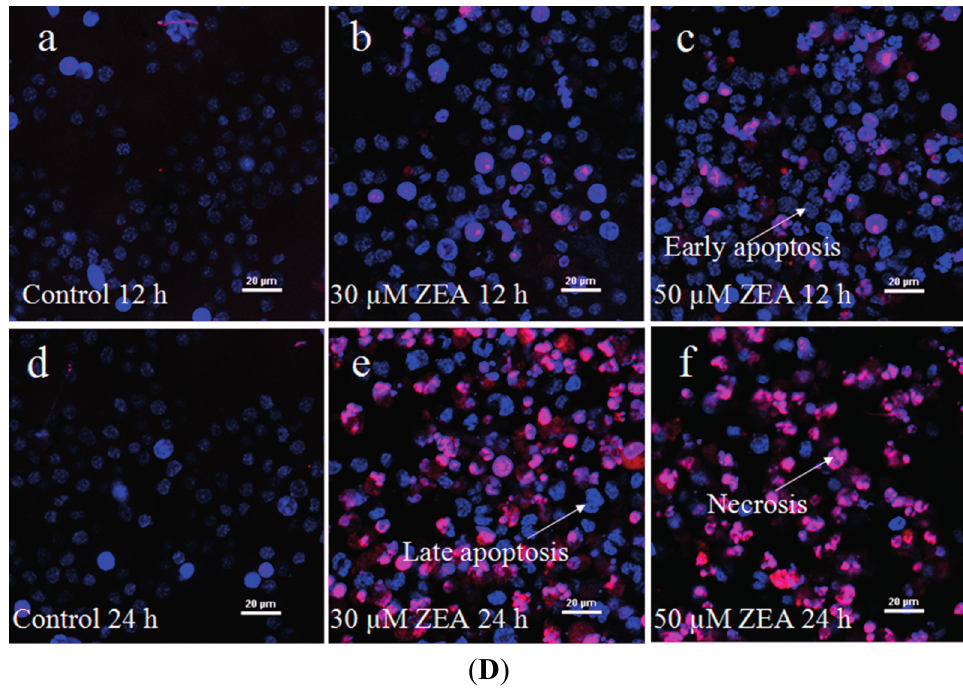
Figure 1. ZEA induces cell death in RAW 264.7 macrophages. ( A ) ZEA reduced the viability of RAW 264.7 macrophages in a dose-dependent manner. Cells were treated with 0, 10, 20, 30, 40, 50, 80 and 100 µM ZEA for 24 h and then processed for the MTT assay; ( B , C ) Apoptosis was detected via fl ow cytometry. B1 is the part of cell death caused by mechanical damage, B2 is the part of late apoptotic or necrotic cells, B3 is the part of the normal cells, and B4 is the part of early apoptotic cells. After exposure to 0, 30, and 50 µM ZEA for 24 h, RAW 264.7 macrophages were collected for Annexin V-PE/7-AAD staining followed by fl ow cytometric analysis. The statistical analysis is shown in the bar graphs. Data are presented as the mean ± SEM of three independent experiments. Bars with different letters are significantly different ( p < 0.05); and ( D ) Representative photomicrographs of RAW 264.7 macrophages stained with Hoechst 33342 and PI fl uorescent dye after exposure of the cells to 0 µM ZEA for 12 h ( a ); 30 µM ZEA for 12 h ( b ); 50 µM ZEA for 12 h ( c ); 0 µM ZEA for 24 h ( d ); 30 µM ZEA for 24 h ( e ); and 50 µM ZEA for 24 h ( f ). Apoptotic cells were characterized as having condensed or fragmented nuclei that stained deep blue, while necrotic cells were stained deep blue and deep red. Bar = 20